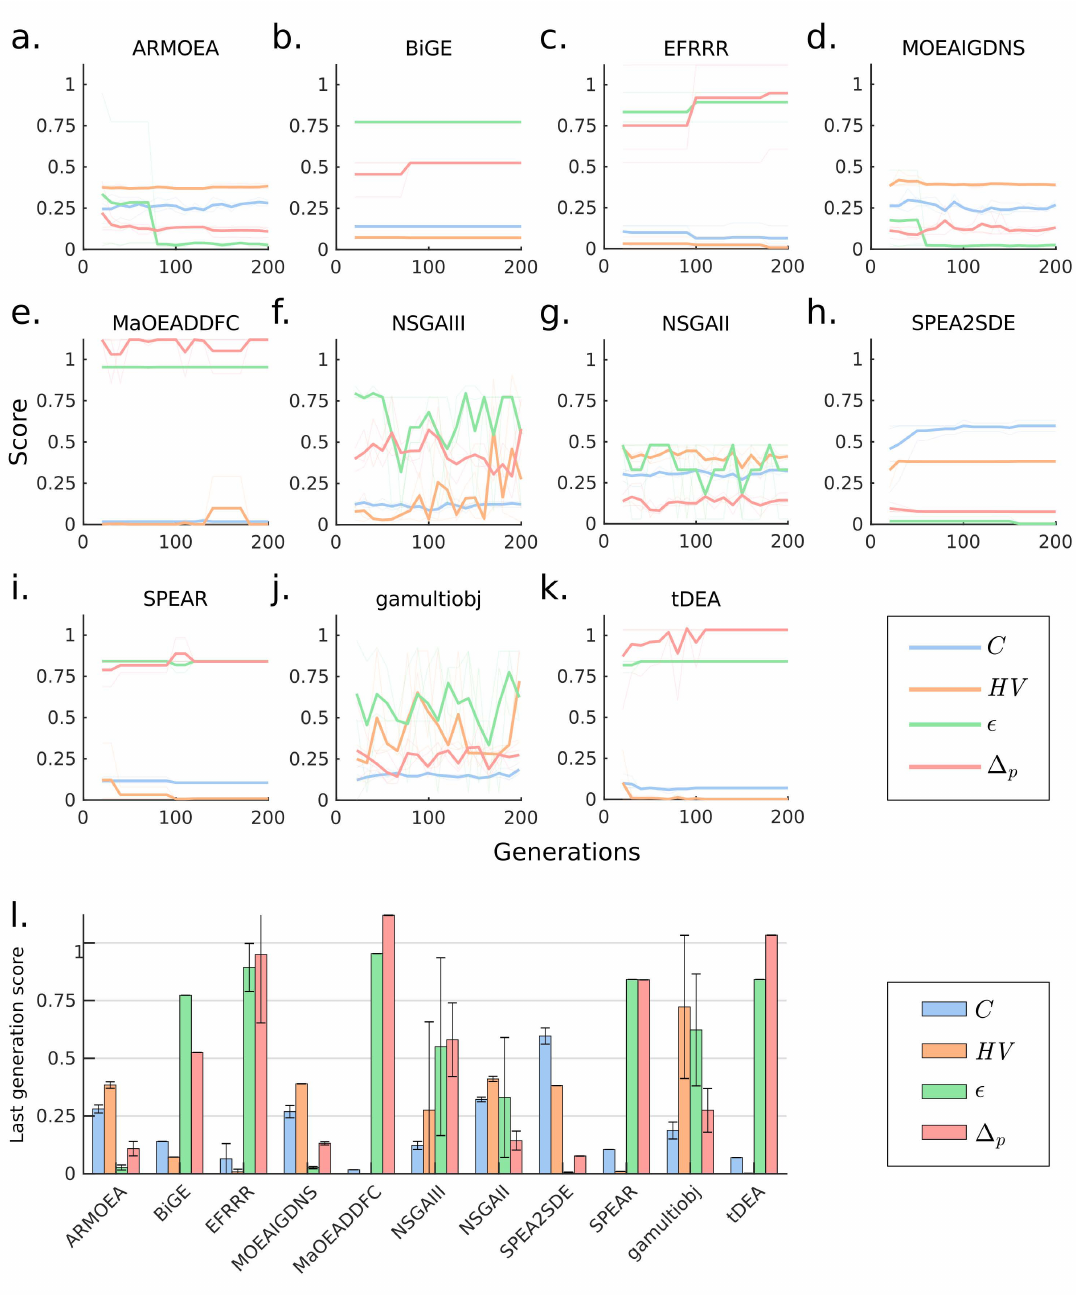
Figure 3. Comparison of MOEAs for a 10-objectives design problem. ( a – k ) Generation-dependent performance metrics for various MOEAs. ( l ) Performance metrics for various MOEAs at the last